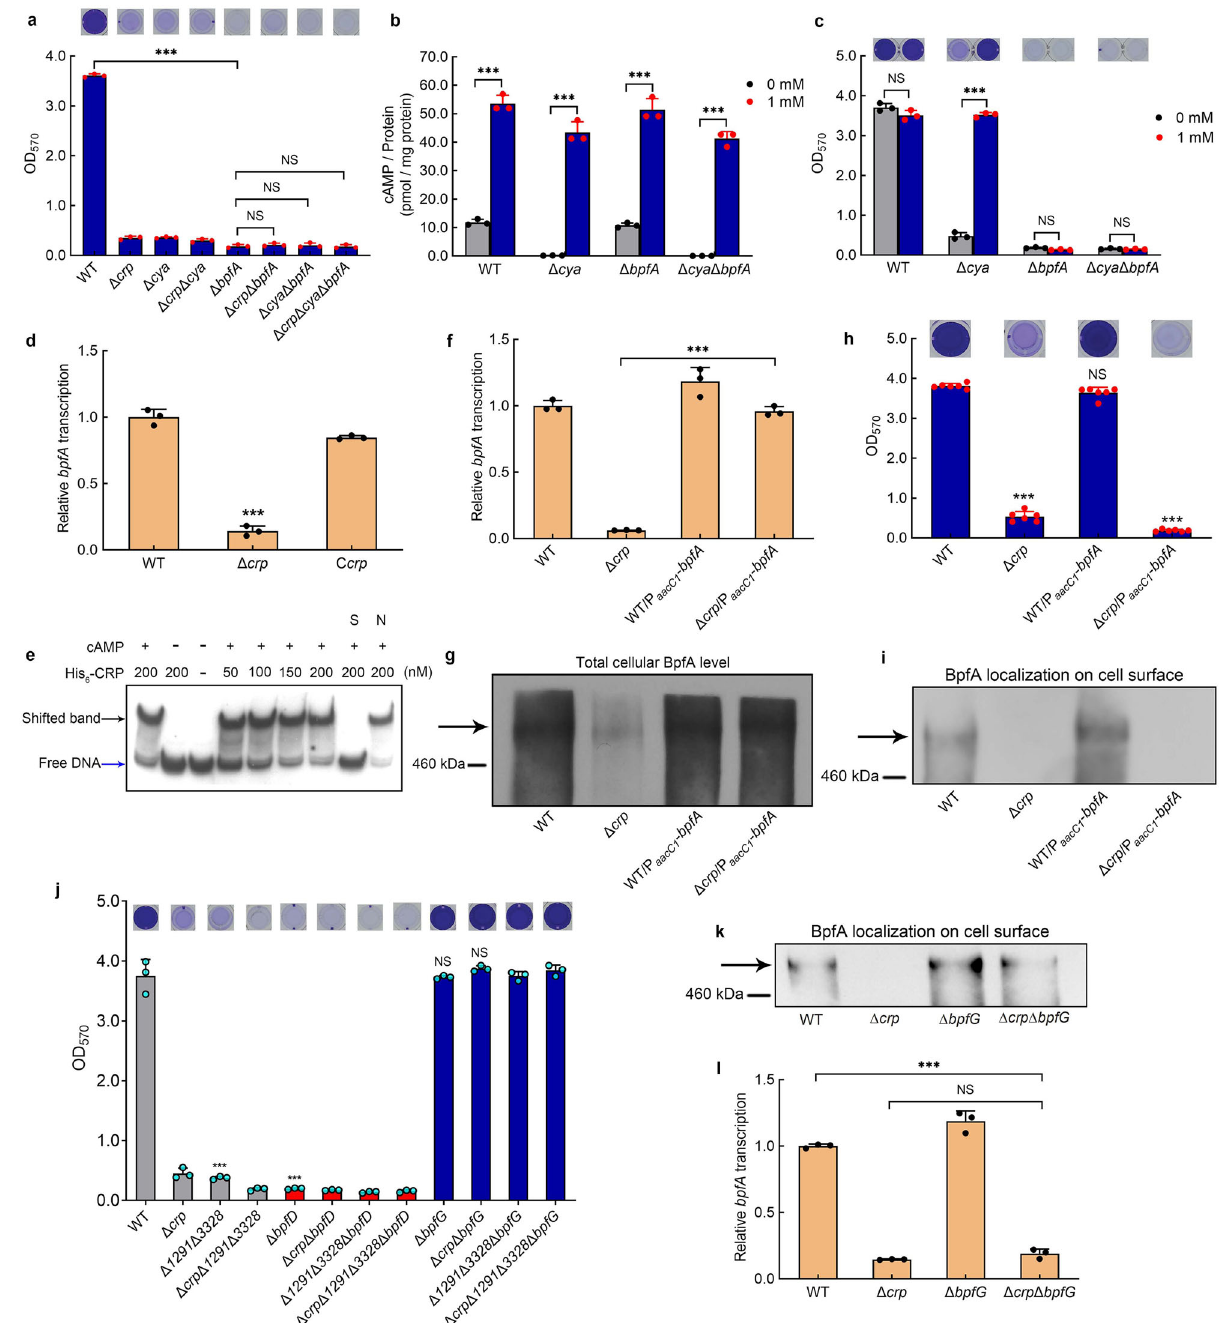
Fig. 3 cAMP-CRP maintains bio fi lm independently of its regulation of bpfA transcription. a Bio fi lm biomass ( n = 3 independent samples). b Intracellular cAMP concentration with adding 1 mM exogenous cAMP to the culture medium vs. control ( n = 3 independent samples). c Bio fi lm biomass with adding 1 mM exogenous cAMP to the culture medium vs. control ( n = 3 independent samples). d Transcriptional analysis of bpfA ( n = 3 independent samples). e EMSA of cAMP-CRP binding to bpfA promoter ( bpfA -pro). The His 6 -CRP (Lane – ), labeled probe was incubated in the absence of His 6 -CRP. The concentrations of His 6 -CRP are shown above the fi gure. The binding speci fi city was con fi rmed by competitive assays with a 300-fold excess of unlabeled speci fi c probe bpfA -pro (lane S) or unlabeled nonspeci fi c competitor DNA (probe recA ) (lane N). The cAMP (Lane – ), labeled probe was incubated in the absence of cAMP. The cAMP (Lane + ), labeled probe was incubated in 1 μ M cAMP. f The comparison of bpfA transcription between the native bpfA promoter and the constitutive promoter P aacC1 ( n = 3 independent samples). g Western blotting detection of the total content of cellular BpfA protein. h Bio fi lm biomass ( n = 6 independent samples). i Western blotting detection of BpfA localization on the cell surface. j Bio fi lm biomass ( n = 3 independent samples). k Western blotting detection of BpfA localization on the cell surface. l Transcriptional analysis of bpfA ( n = 3 independent samples). All strains used in ( a – d , f – l ) were cultured for 30 h in the bio fi lm state. Insets in ( a , c , h , j ) are the bio fi lm pictures of crystal violet dyeing. Data in ( a – d , f , h , j , l ) are shown as the mean ± SD. Two-sided Student ’ s t test was used in ( a – d , f , h , j , l ) to analyze the statistical signi fi cance (NS: No signi fi cance. *** p < 0.001). Source data are provided as a Source Data fi le.